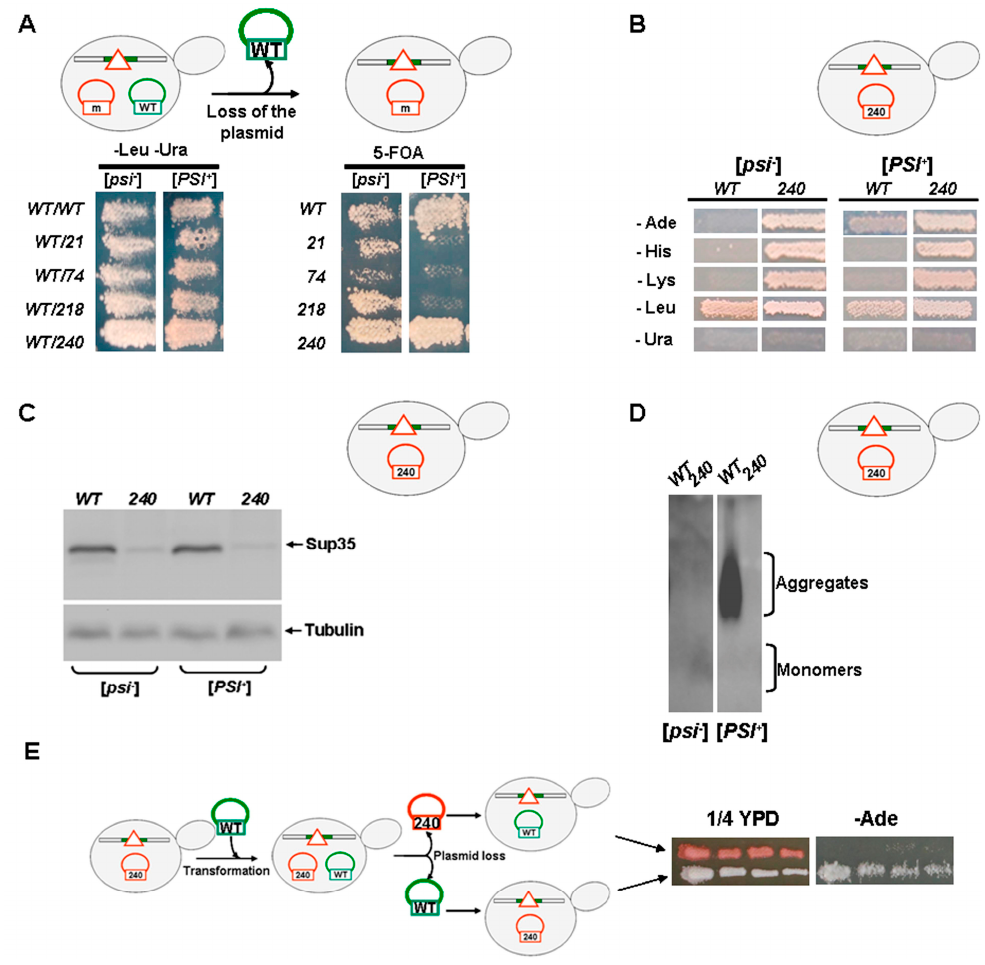
Figure 4. Nonsense mutations in SUP35 lead to the lethality or the prion loss in the [ PSI + ] haploids. ( A ) Combination of the [ PSI + ] prion with sup35-21, sup35-74 or sup35-218 mutations is lethal. Strains 7A-D832 [ psi − ] and 10-7A-D832 [ PSI + ] containing two plasmids: one, with wild-type SUP35 , and the second, with sup35-n, were replica plated on 5-FOA media to select against SUP35 plasmid. Only [ PSI + ] cells bearing sup35 - 240 were able to grow after 5 days of incubation at 30 ◦ C. ( B ) Yeast cells selected as shown on the Panel A, were plated on media lacking adenine (-Ade), histidine (-His), or lysine (-Lys) to test nonsense suppression, as well on media lacking leucine (-Leu) or uracil (-Ura) to confirm the presence [ LEU2 ] and absence of [ URA3 ] plasmid, respectively. Growth after 5 days of incubation at 30 ◦ C is shown. ( C , D ) Yeast cell lysates from transformants shown on the Panel B were characterized by SDS-PAGE (Panel C) or by SDD-AGE (Panel D) with immunoblotting for Sup35. Full-length Sup35 and tubulin are shown by arrows. ( E ) [ PSI + ] cells shown on the Panel B were transformed by SUP35 plasmid, whereupon spontaneous loss of [ sup35-n LEU2 ] or [ SUP35 URA3 ] plasmids was performed. Growth of cells bearing only one plasmid on 1 / 4 YPD or adenine-lacking medium after 5 days of incubation at 30 ◦ C is